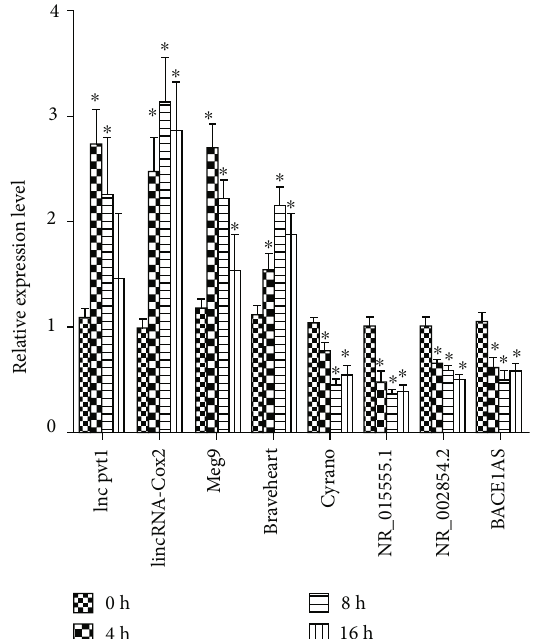
Figure 3: Validation for the expression of signi fi cant dysregulated lncRNAs. The RAW264.7 cells were treated with CpG ODN1826, and the RNA was extracted at di ff erent time points (0 h, 4 h, 8h, and 16 h) after stimulation. The relative expression levels of 8 selected lncRNAs were determined by qRT-PCR. Data are presented as mean ± SD . ∗ p < 0 : 05 .